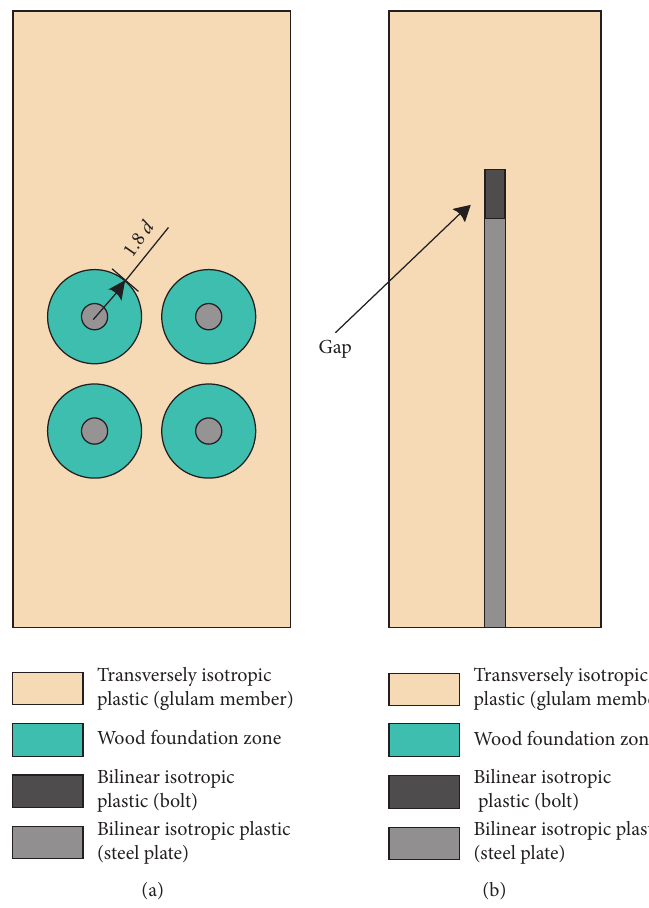
Figure 4: An example of the distribution zones of different material models. (a) Front view. (b) Side